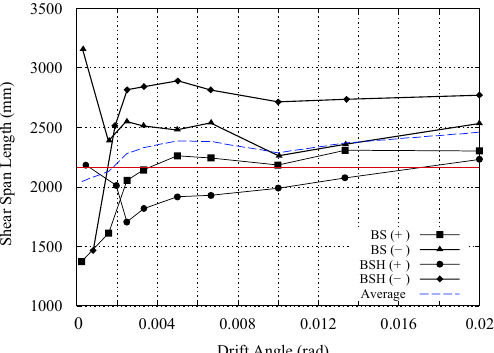
Figure 13. Shear span lengths assumed in the tests for the beam specimen.